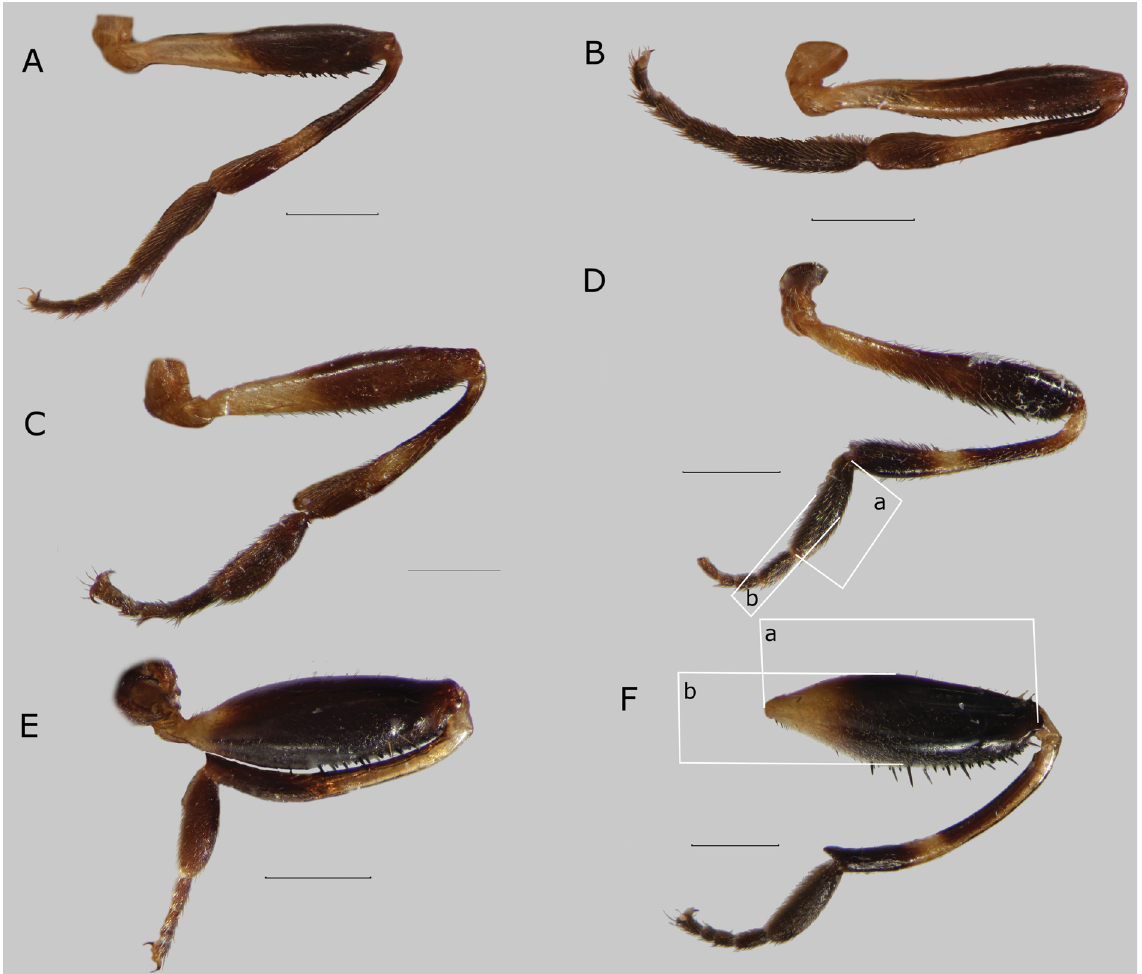
Fig. 19. Metaleg, anterior view. A . Sphegina (Sphegina ) abbreviata sp. nov., paratype, ♀ , Nepal. B . S. ( S. ) angustata sp. nov., paratype, ♀ , Nepal. C . S. ( S. ) uncinata Hippa, van Steenis & Mutin, 2015, ♂ , Myanmar. D . Sphegina (Asiosphegina) brevipilis sp. nov., paratype, ♂ , China, abbreviations: a = length of basitarsus of metatarsus; b = width of basitarsus of metatarsus. E . S. (A.) collicola sp. nov., holotype, ♂ , Malaysia. F . S. (A.) crinita sp. nov., paratype, ♀ , Java, abbreviations: a = length of metafemur; b = width of metafemur. Scale bars = 0.5